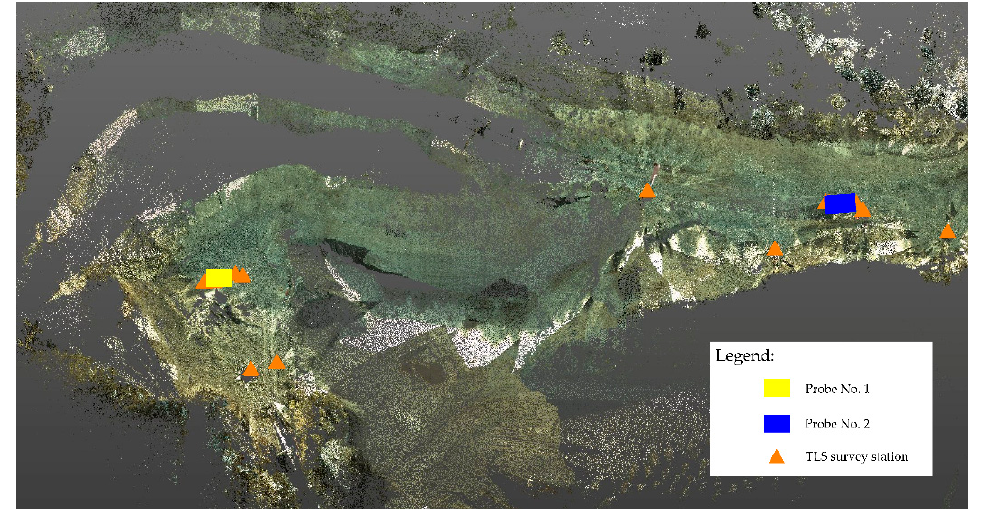
Figure 9. The overall situation of the geodetic survey.